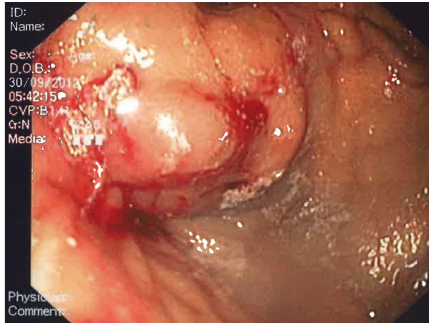
Figure 2: Endoscopic image of hardened gastric varices after intravariceal injection with